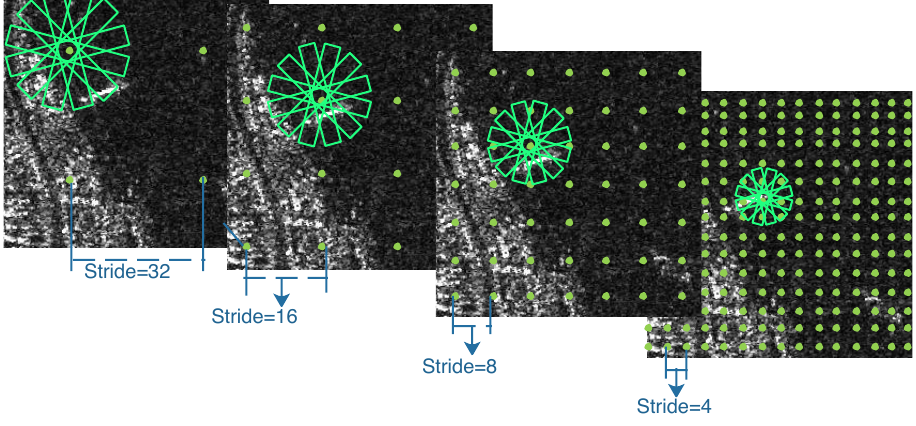
Figure 6. Anchor generation in an SAR image.